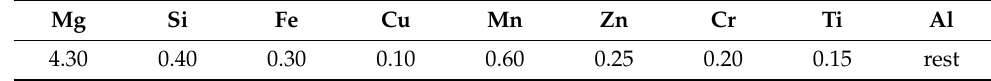
Table 1. Chemical composition of Al5083